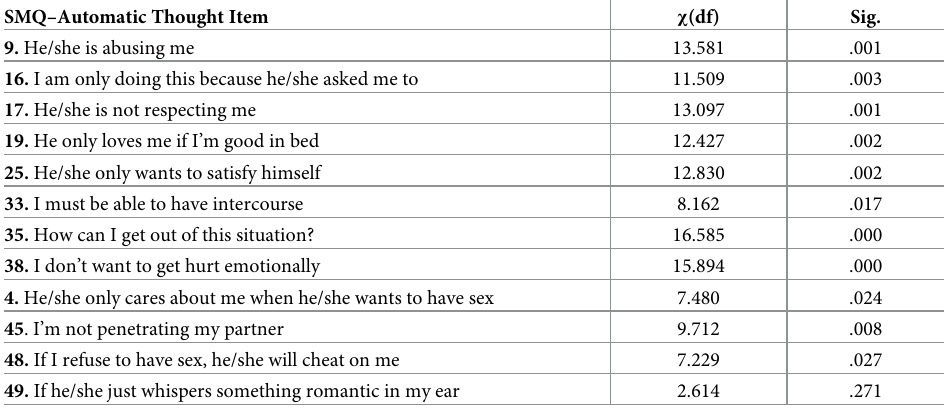
Table 4. List of items showing a significant association between disability condition (presence/absence) and types of emotion (negative and positive) scale at p < .05 level. SMQ–Automatic Thought